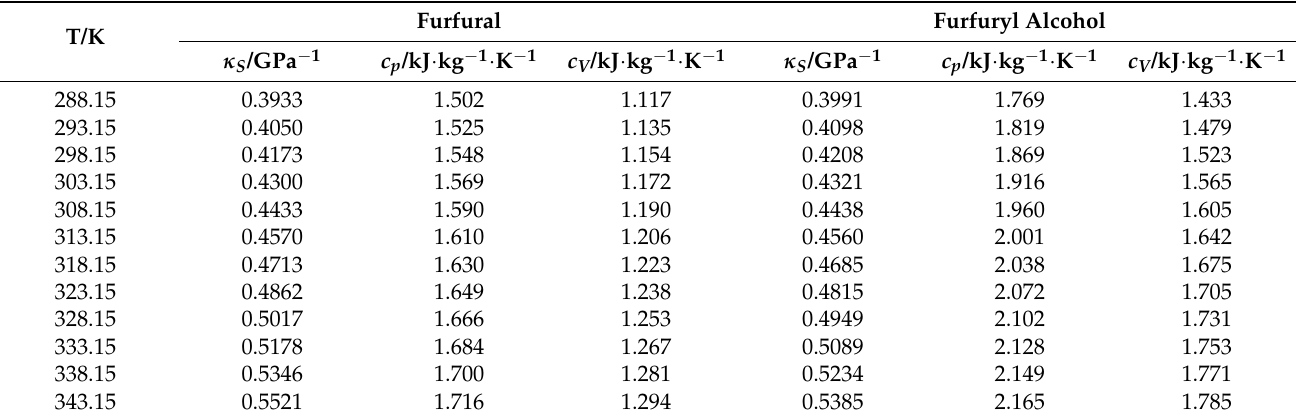
Table 6. The isentropic compressibility, κ S , the isobaric specific heat capacity, c p , and the isochoric specific heat capacity, c V , of furfural and furfuryl alcohol at 0.1 MPa